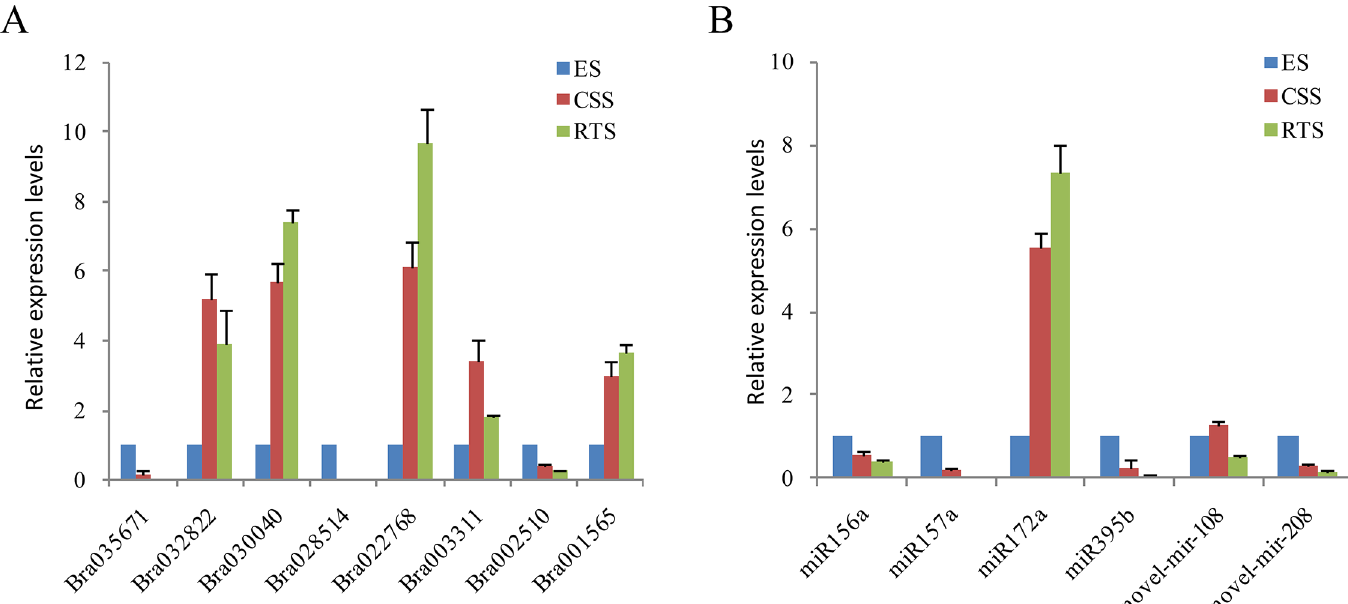
Fig 3. qRT-PCR validation of DEGs and DEMs from high-throughput sequencing analyses. (A) qRT-PCR validation of DEGs from high-throughput RNA sequencing analyses. Relative expression levels were calculated using actin2 as the reference gene using the formula 2 - 44 Ct . The values indicate means of three biological replicates ± standard error. (B) qRT-PCR validation of DEMs from high-throughput sRNA analyses. Relative expression levels were calculated using spliceosomal RNA U6 as the reference gene using the formula2 - 44 Ct . The values indicate means of three biological replicates ± standard